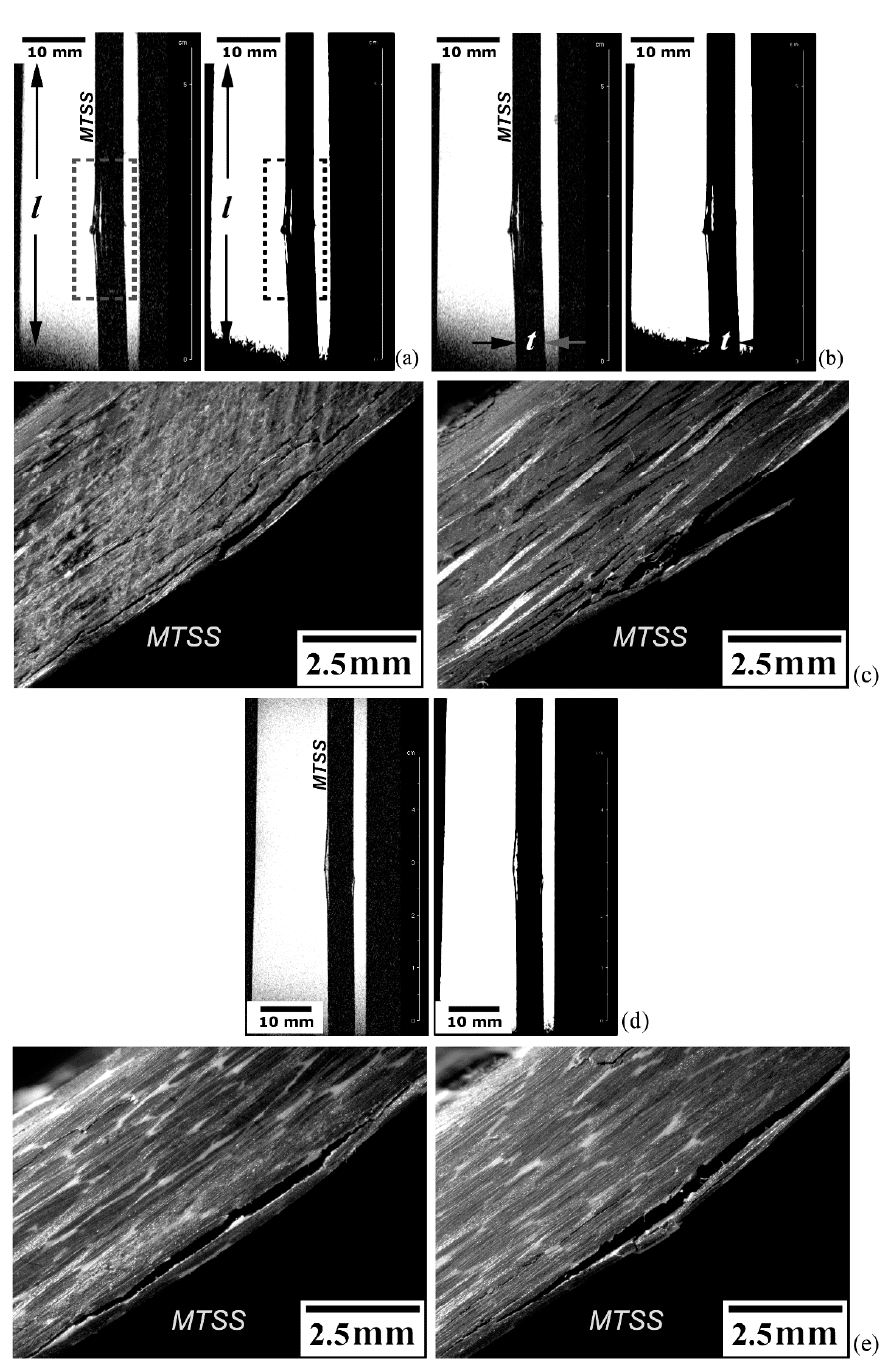
Figure 9. Delaminated FRP specimens: ( a ) S-view (respectively, original and after digital processing images) at the mid-width of EPX-CF via the 2D-RARE protocol; ( b ) via the 2D-FLASH protocol; ( c ) stereoscopic views of both l-t surfaces of the specimen; ( d ) S-view (original and after digital processing images, respectively) at the mid-width of PPS-CF laminate; and ( e ) stereoscopic views of both l-t surfaces of the specimen. MTSS is indicated.